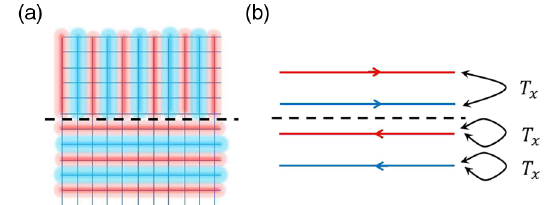
FIG. 6. (a) Illustration of the domain wall between two topo- logical nematic states (1,0) (upper half) and (0,1) (lower half). (b) Illustration that the left- and right-moving edge states along the domain wall transform differently under lattice translation T . The right movers from the (1,0) state are exchanged by T x while the left movers from the (0,1) state are separately trans- lation